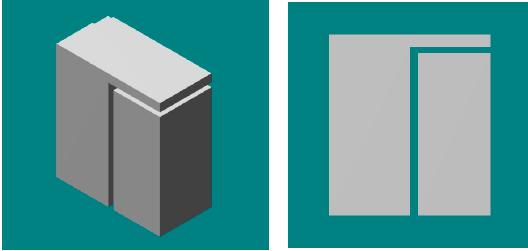
Figure 8. Computer-aided design (CAD) model of an overhang part with a heat support.